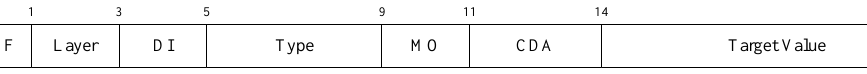
Figure 9. SCHC fixed size context option.